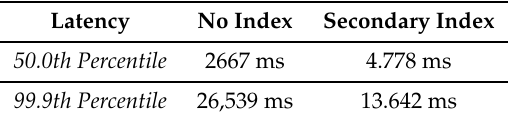
Table 5. Impact secondary index on